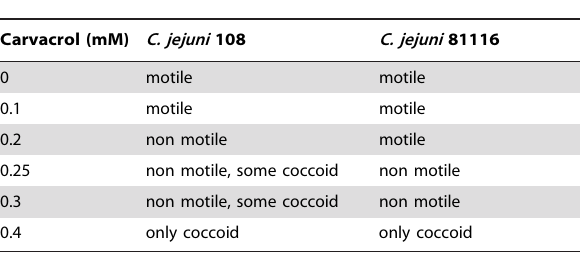
Table 1. Effect of carvacrol on the motility and physiology of C. jejuni strains 108 and 81116 cultured (16 h) in HI broth with shaking in the absence or presence of the indicated concentrations of carvacrol.